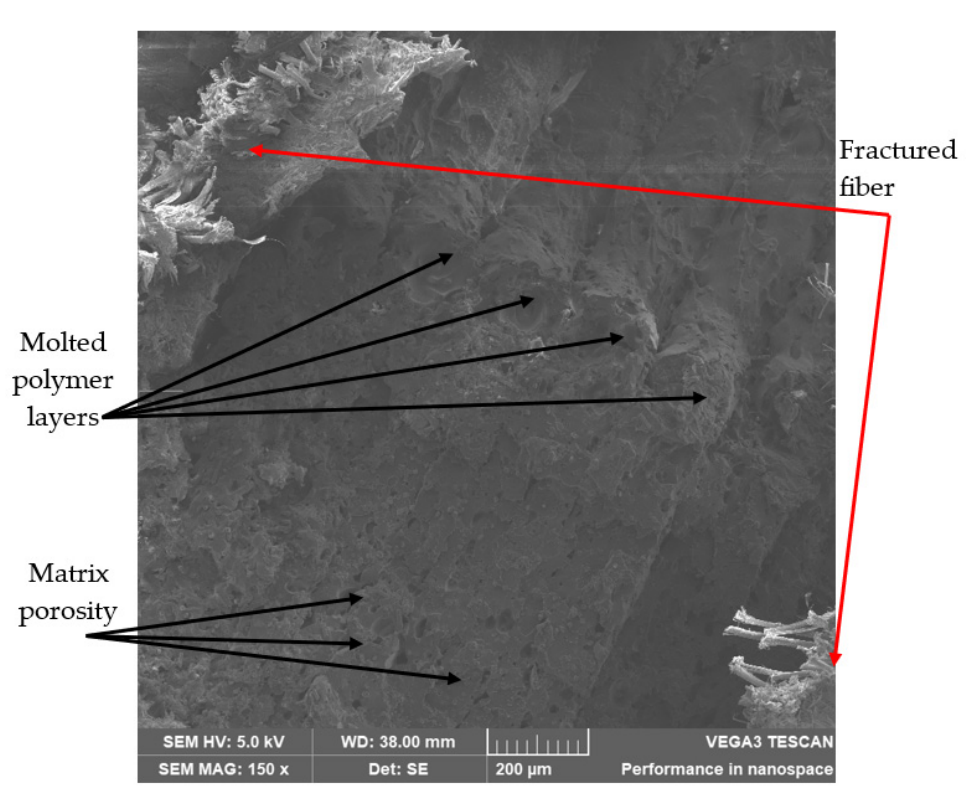
Figure 14. Onyx ® matrix showing porosity .